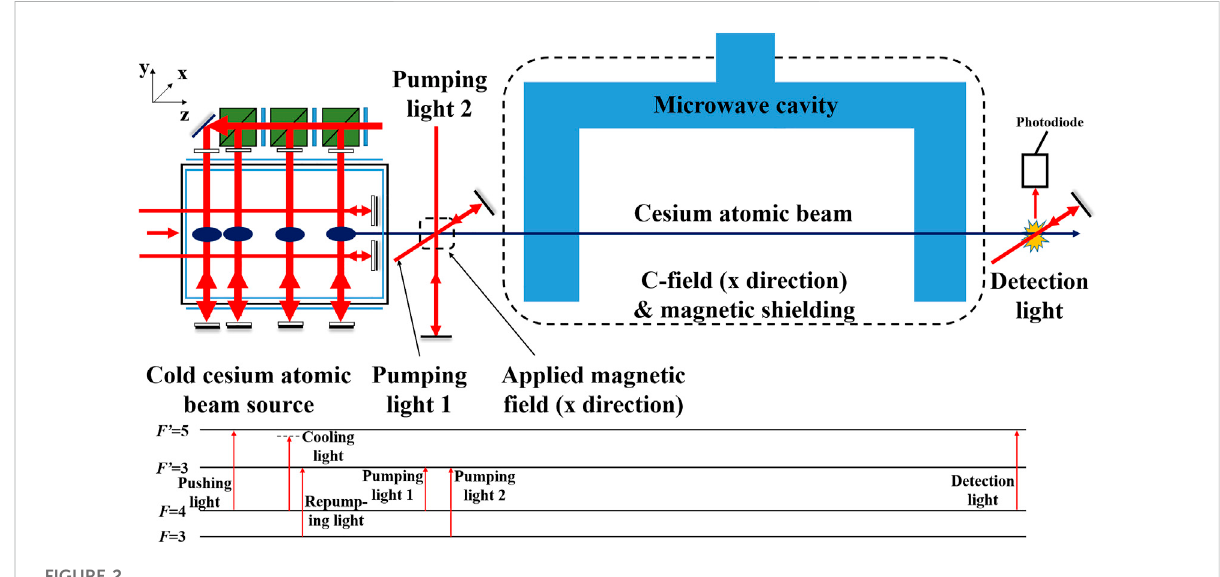
FIGURE 2 Schematic of the optically pumped cold cesium beam atomic clock. The upper part is the detailed structure of the atomic clock, and the lower part is a diagram of the transitions of Cs D 2 line used in each part of the atomic